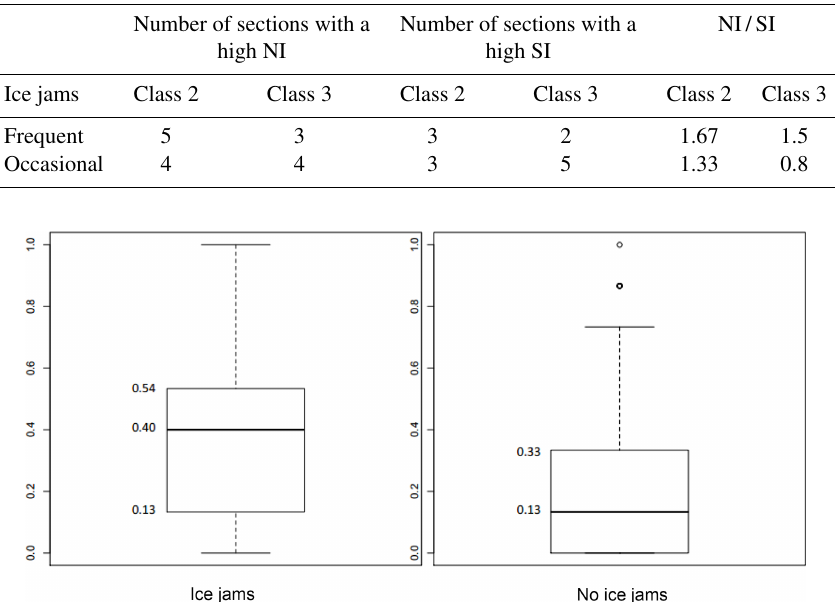
Figure 5. Box plot of the IJPI values on the Chaudière River. Graph on the left is for 250m river sections where ice jams were reported. Graph on the right is for river sections with no ice jam listed. Numbers represent the median, first and third quartiles.